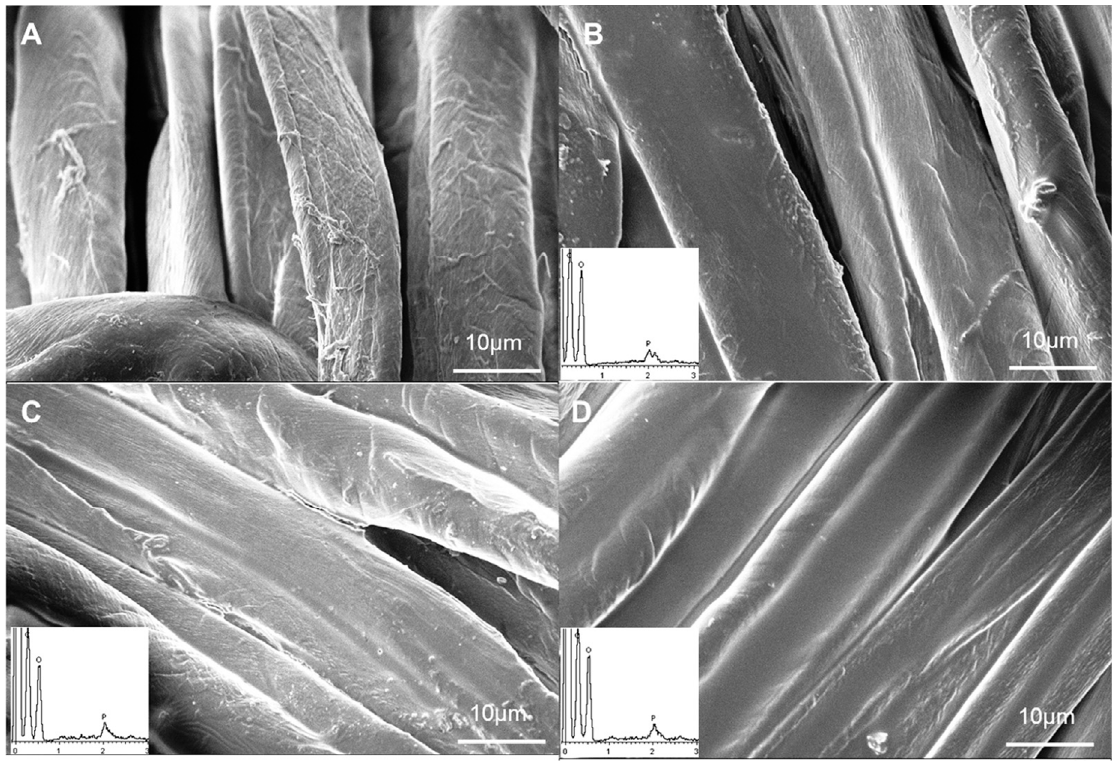
Figure 6. SEM micrographs of COT ( A ), COT_DNA 5% ( B ), COT_DNA 10% ( C ) and COT_DNA 19% ( D ) at 5000× and elemental analyses. Reproduced with permission from [44]. Copyright 2013, Elsevier.